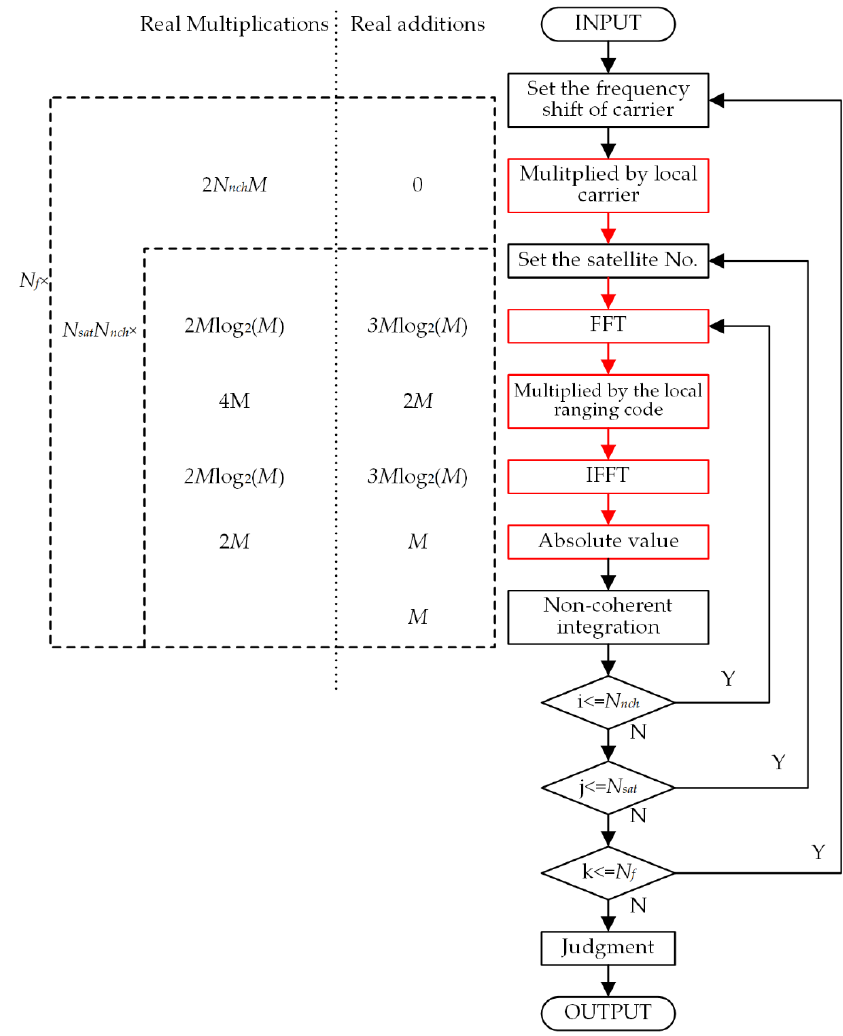
Figure 6. The flow diagram and the computational amount of the non ‐ coherent acquisition scheme.